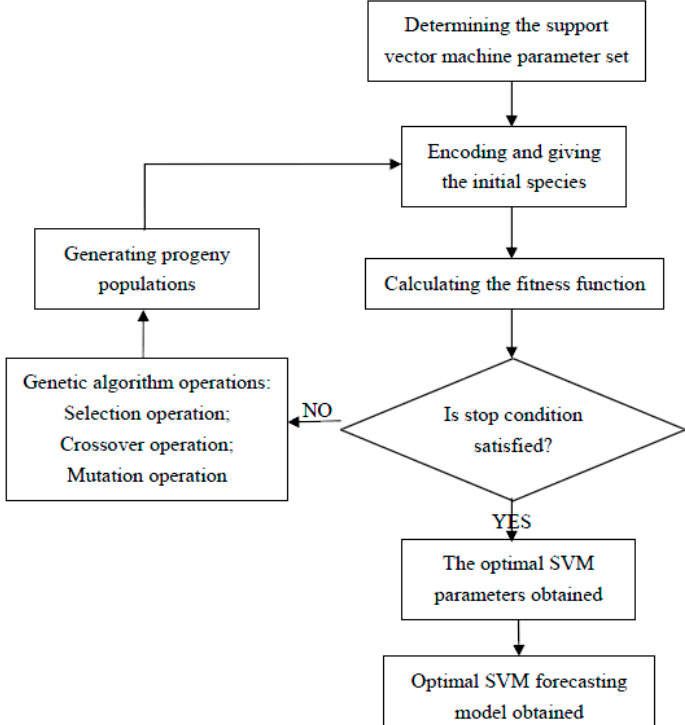
Figure 1. Flowchart for GA-SVM model.